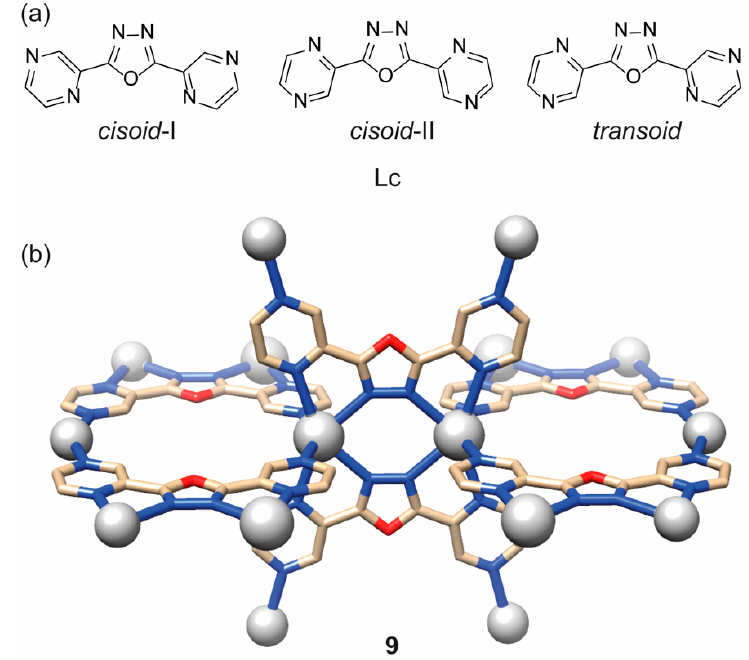
Figure 4. ( a ) Structures of the ligand 2,5-bis(pyrazine)-1,3,4-oxadiazole (Lc) and ( b ) its Ag(I) coordination polymer. Picture is adapted from reference [12] and was generated with Chimera software [17] using the original CIF